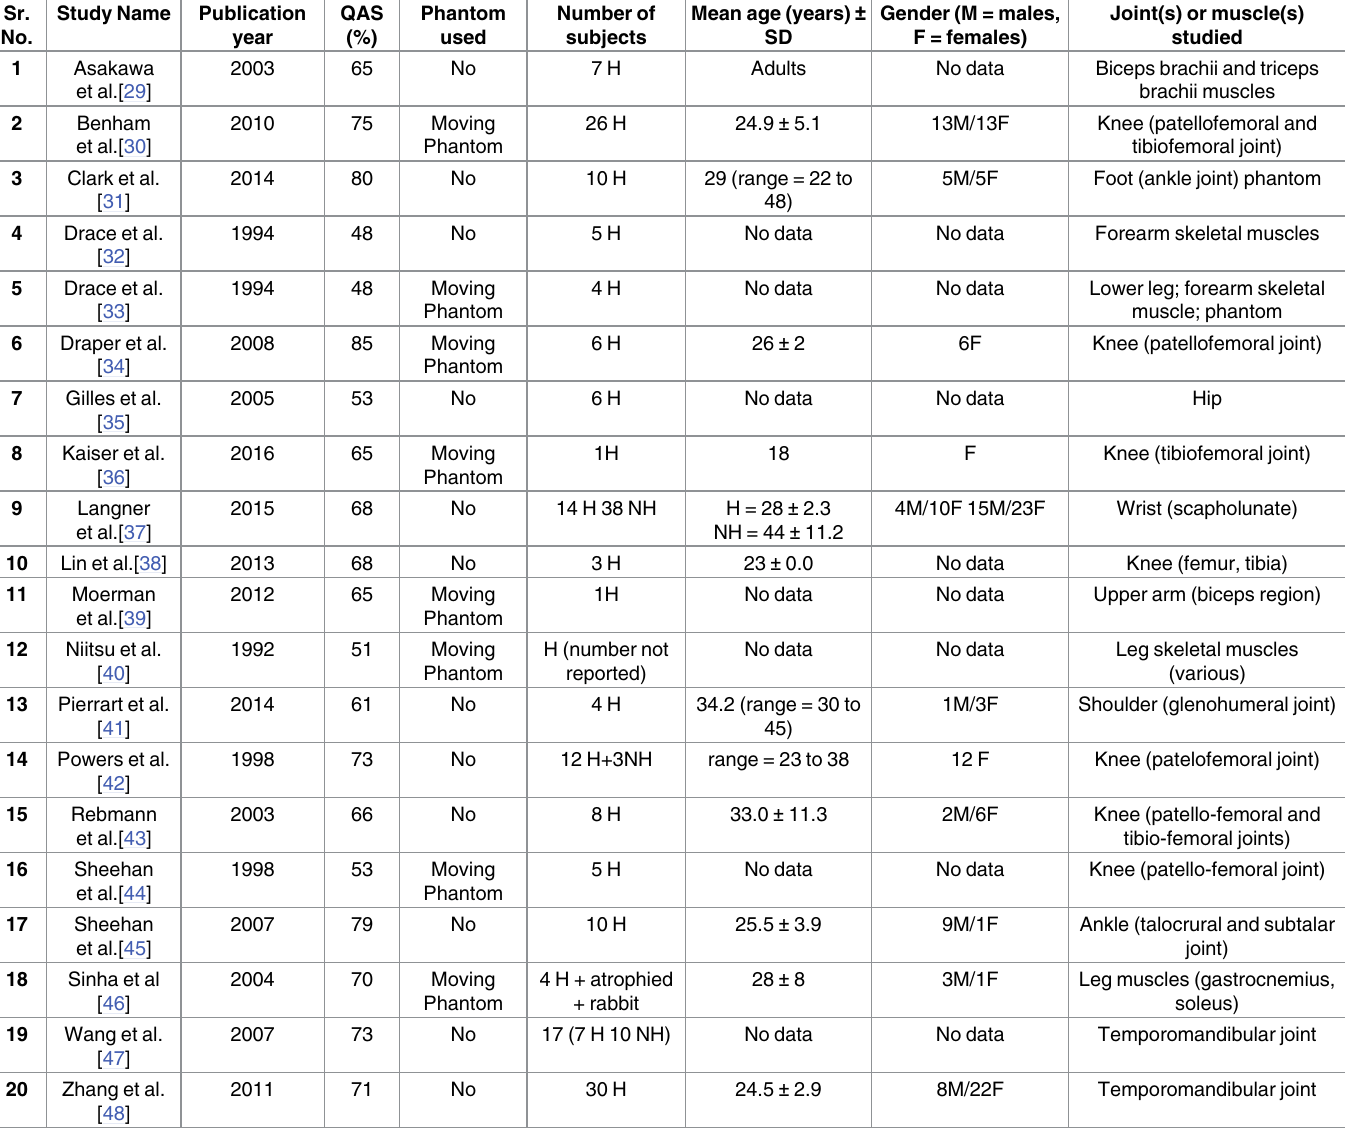
Table 2. Description of study population and joint or muscle studied for each selected